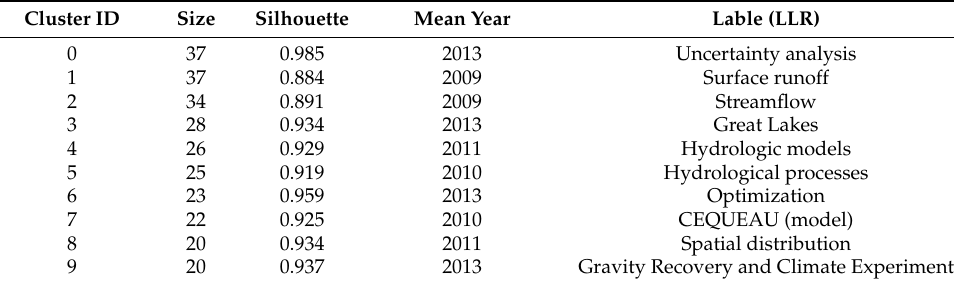
Figure 8. Keyword co-occurrence network map. Table 4. Major clusters of keyword.